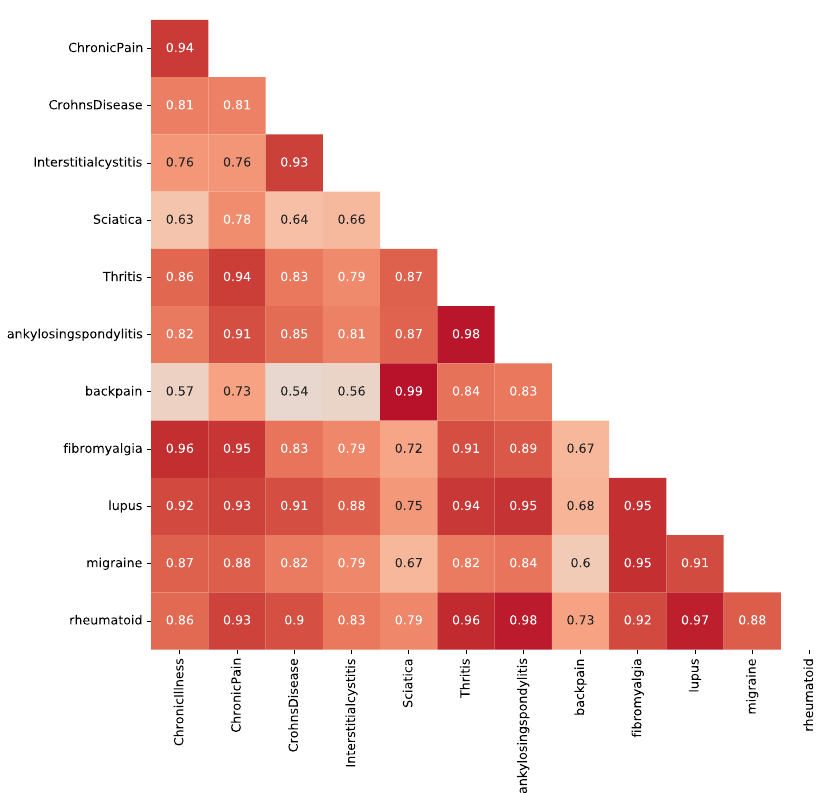
Figure A1. Similarity graph between subreddit centroids (nodes). Edges between two nodes represent similarities ≥ 0.96. Nodes are colored by subreddit. The adjacent label indicates the corresponding subreddit.